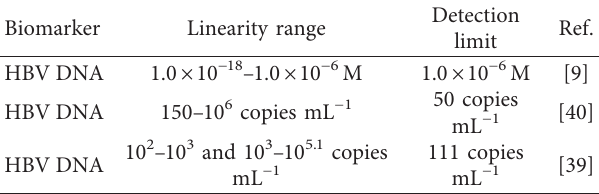
Table 5: EIS detection of